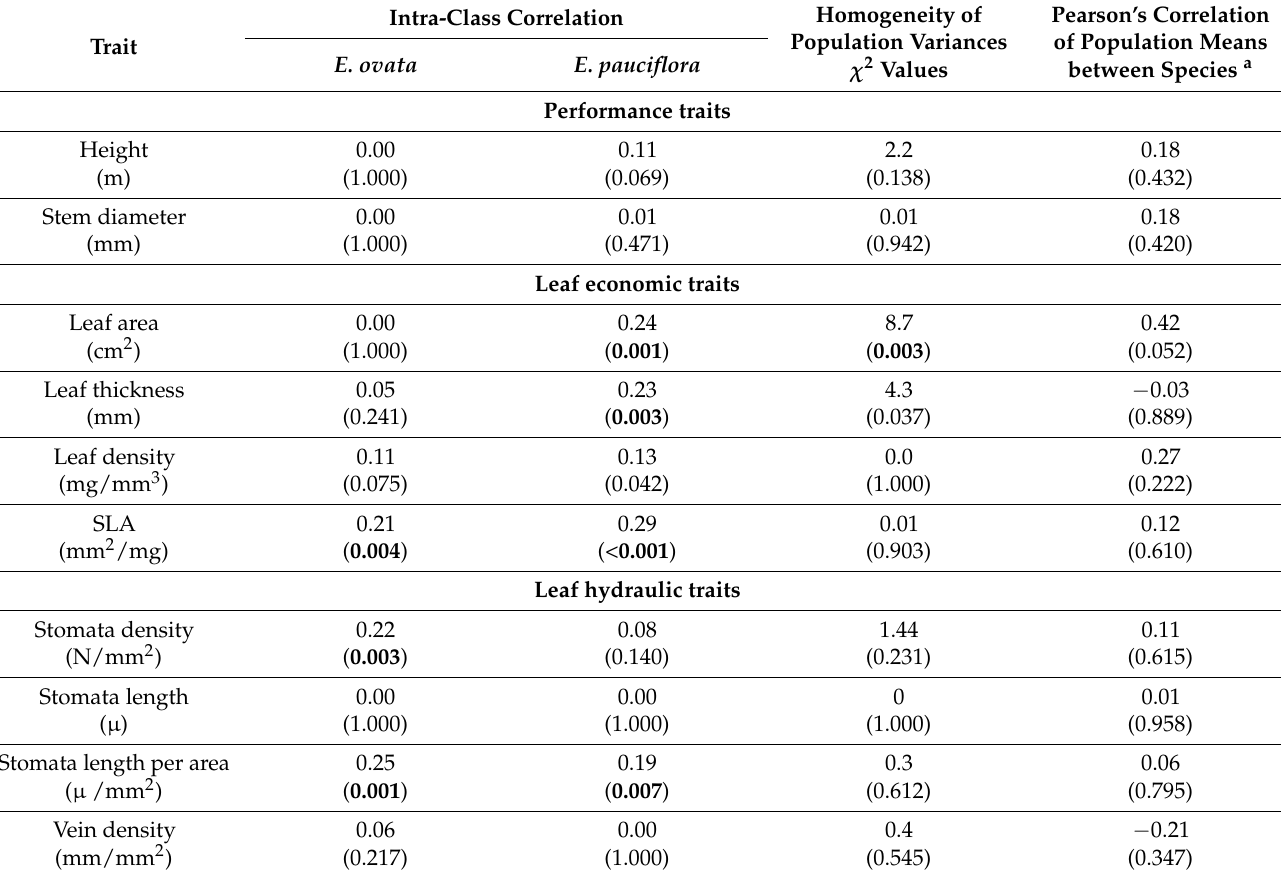
Table 2. Population intra-class correlations, homogeneity of population variances across species, and the Pearson’s correlations of population means between species for the variables (performance and leaf traits) measured from 22 co-occurring populations of E. ovata and E. pauciflora . The p -values associated with tests of whether population variances or population–mean correlations differed significantly from zero, and whether species differed in population variances, are given in parentheses. (Bolded probability values represent statistically significant results at the 5% nominal level even after the Bonferroni adjustment was applied within each